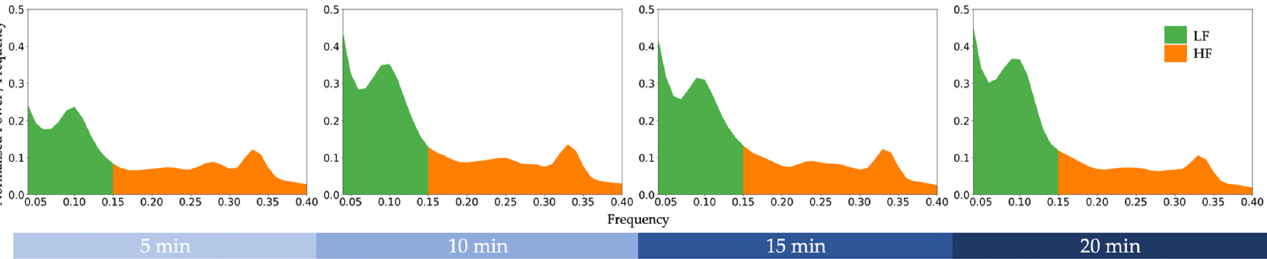
Figure 2. Grand averaged power spectral density graph of the original data (sampled at 2000 Hz) across all participants during a cognitively fatiguing task. LF = low-frequency power. HF = high-frequency power.